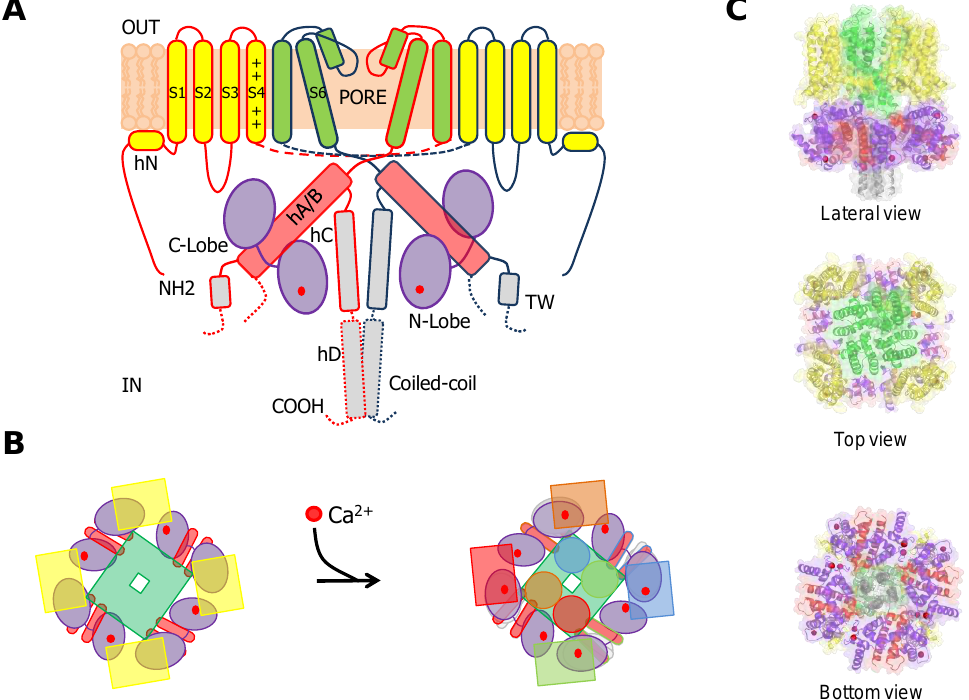
Figure 12. Representation of a KCNQ channel. ( A ). Transmembrane regions are in yellow for the VSD, green for the PD and CaM is in purple. The cytosolic helix parallel to the membrane before S1 is labeled as hN. Helices A and B, colored in red, are at ~45 ◦ to the membrane under the VSD from the same of subunit. The border is colored red or blue to identify each subunit. To account for swapping, the VSD and PD of two di ff erent subunits are represented continuously. The presumed position of the tetrameric coiled-coil is indicated with dashed lines. ( B ). Realistic representation of the channel view from the top using the same color scheme as in A. Helices A and B are represented in red. On the right, upon Ca 2 + loading (red dots) there is a small movement of helix A. Each subunit has a di ff erent color in this cartoon. ( C ). Structures visualized using then PDB coordinates (5VMS), rendered with Pymol 1.30 using the same color scheme as in panel A.